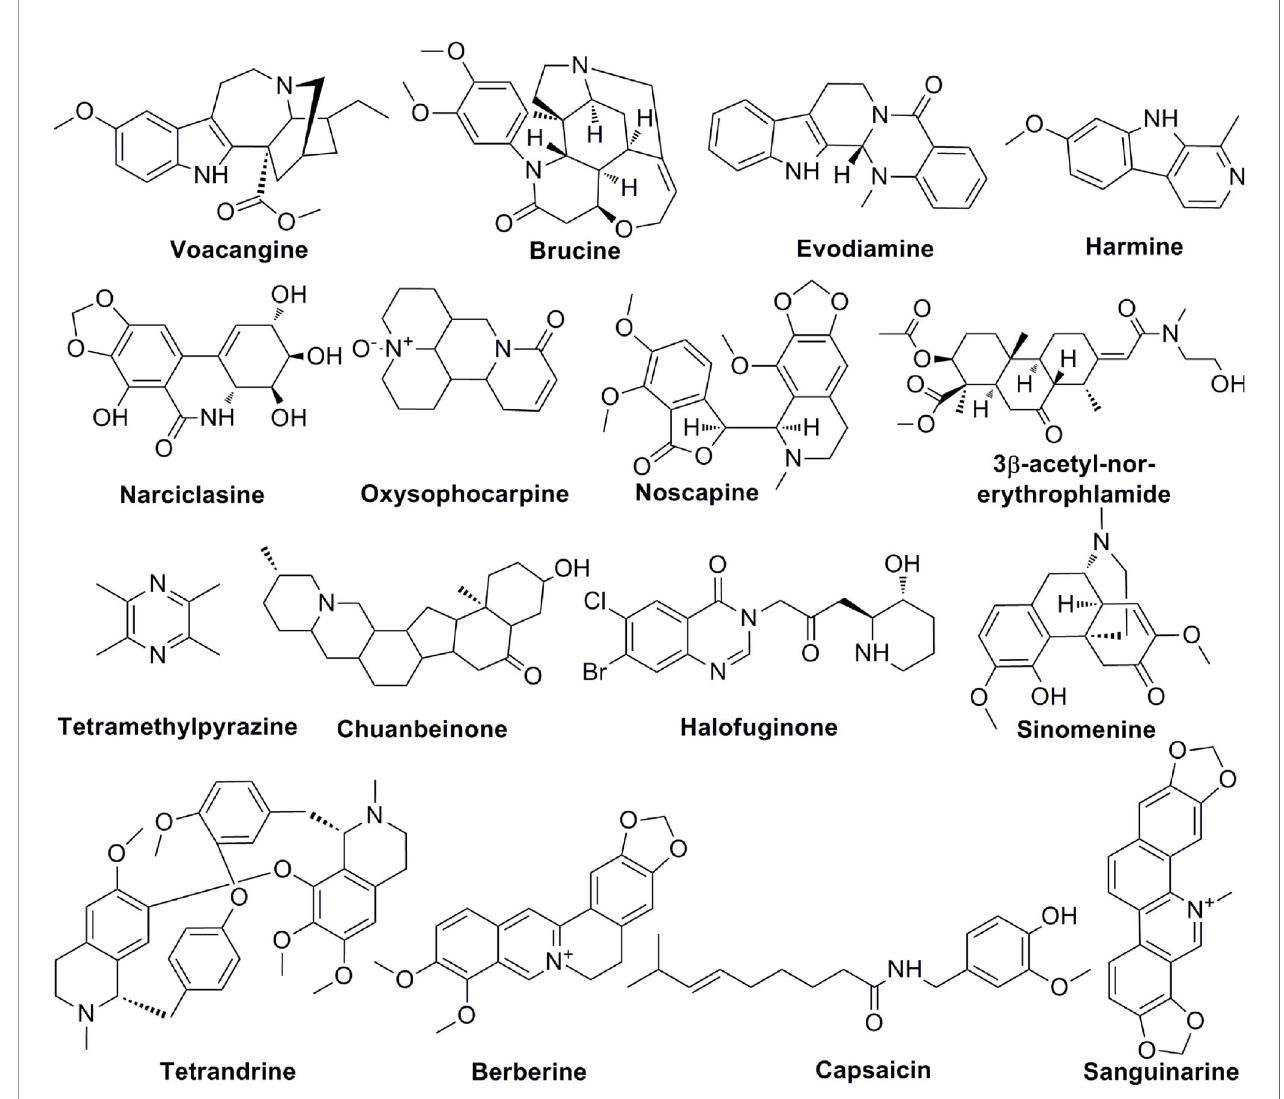
FIGURE 4 | The chemical structures of alkaloids involved in tumor